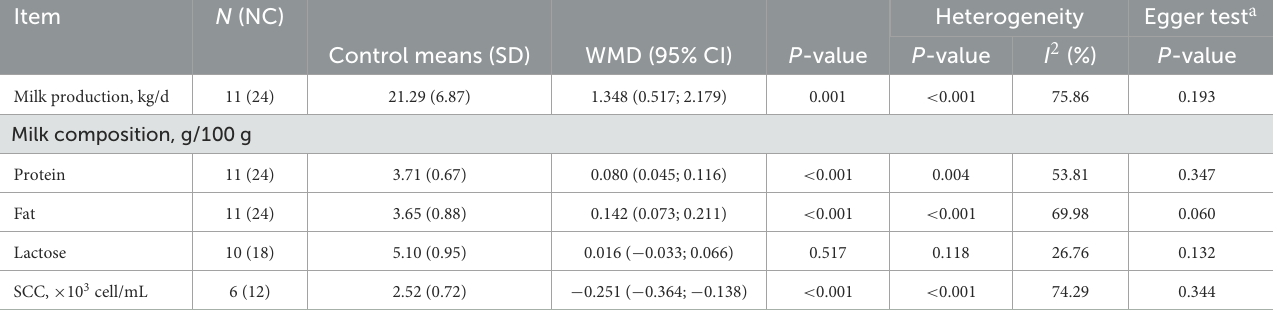
TABLE 6 Milk production and quality of cattle supplemented with